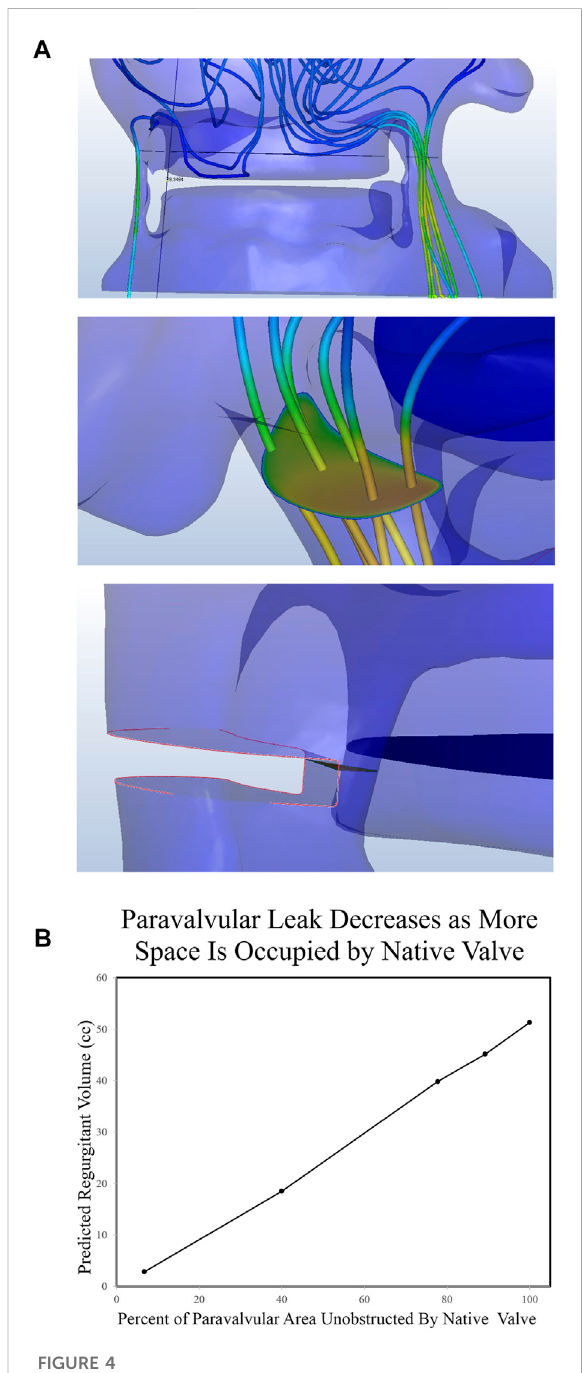
FIGURE 4 Quanti fi cation of Paravalvular Leak from CFD Simulations. (A) Post implantation imaging demonstrated two clinically signi fi cant leaks, both of which were recreated in the CAD software. A plane wasdrawnmidwaythroughtheleakareaandthe fl uxthrough that plane was quanti fi ed. Finally, portions of the paravalvular area were sequentially occluded and leak was quanti fi ed again. (B) The regurgitant volume was then quanti fi ed as a function of the percent paravalvular area that was